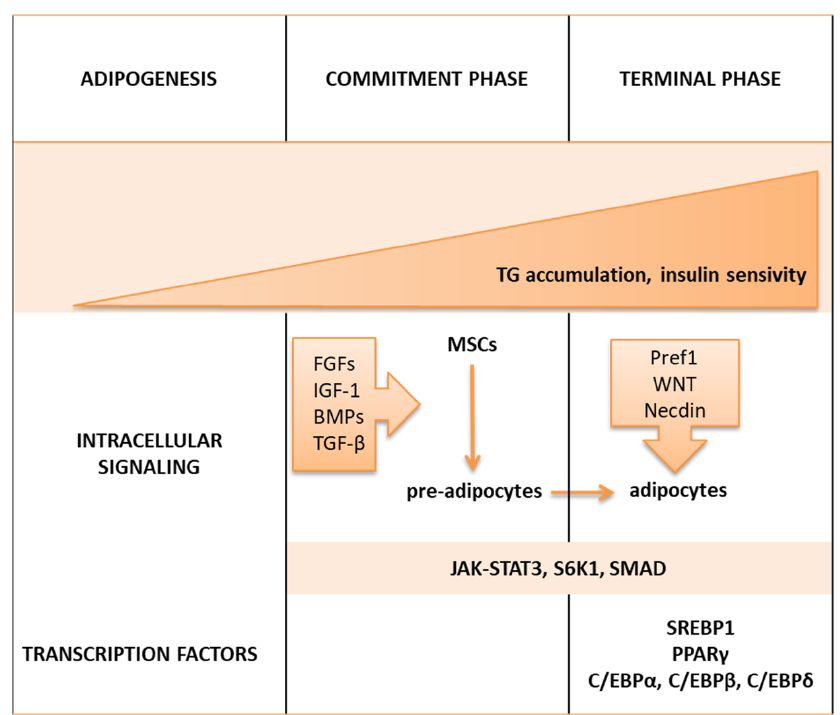
Figure 3. Intracellular molecules and transcription factors involved in adipogenesis. The figure shows the potential molecular mechanism of the adipogenesis-identifying intracellular-signaling network involved. Mesenchymal stem cells (MSCs) subjected to multiple growth factors are transformed into preadipocytes (commitment phase) that, in further steps, are stimulated to also form mature adipocytes with the support of transcription factors (terminal phase). Adipose tissue is considered to be the main storehouse of vitamin D. Due to the abundant expression of VDR in adipocytes, vitamin D affects the expression of multiple genes in these cells also related to adipogenesis. Moreover, vitamin D affects a number of processes, such as apoptosis and inflammatory processes, as well as redox homeostasis and oxidative stress. Abbreviations: JAK-STAT3, Janus kinase-signal transducer and activator of transcription 3; S6K1, ribosomal protein S6 kinase 1; SMAD, SMAD proteins; SREBP1, sterol regulatory-binding protein 1; C/EBP α , β , and δ , CCAAT/enhancer-binding proteins α , β , and δ ; PPAR γ , peroxisome proliferator-activated receptor γ ; Pref1, preadipocyte factor 1; WNT, members of the wingless family; Necdin, melanoma-associated antigen family of proteins; Rb, retinoblastoma protein; FGFs, fibroblast growth factors; IGF-1, insulin-like growth factor 1; BMPs, bone morphogenetic proteins; TGF- β , transforming growth factor β